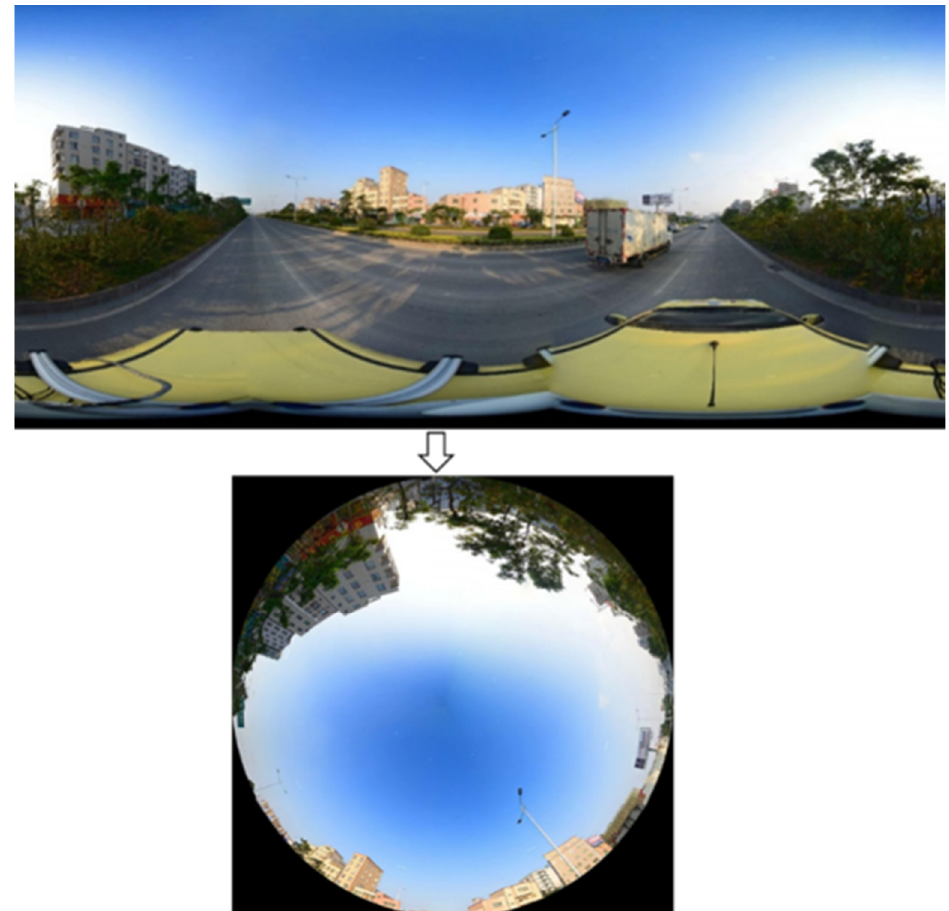
Figure 5. Converting panorama image to fisheye view image.